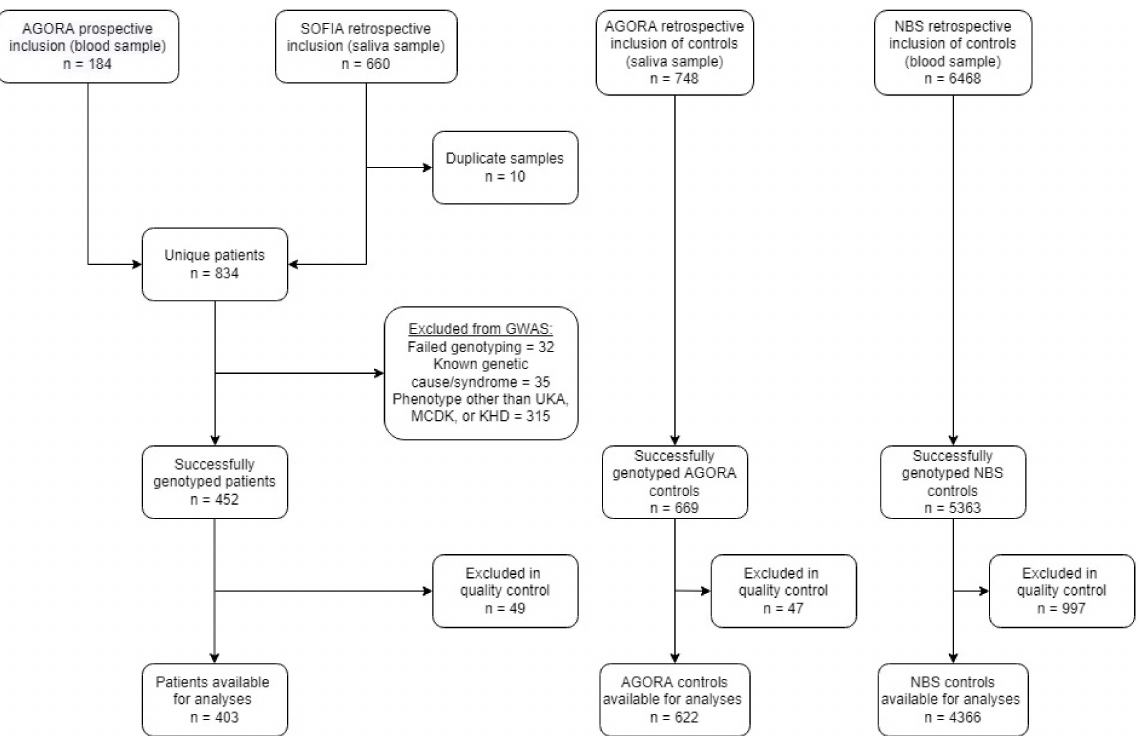
Figure 1. Flowchart of the number of included patients and controls after recruitment, genotyping and quality control. GWAS: genome-wide association study; UKA: unilateral kidney agenesis; MCDK: multicystic dysplastic kidney; KHD: kidney hypo/dysplasia.